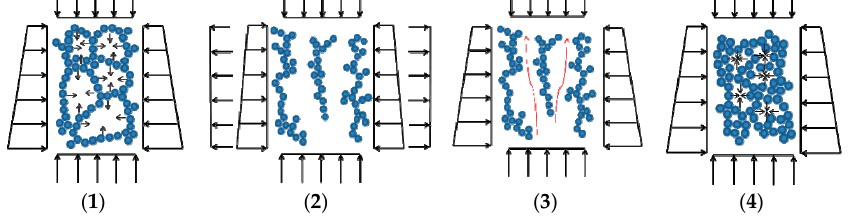
Figure 21. Lateral tensile stress drainage process. ( 1 ) Static equilibrium; ( 2 ) disruption of equilibrium by applied tensile stress; ( 3 ) formation of seepage channels; ( 4 ) drainage followed by compaction.